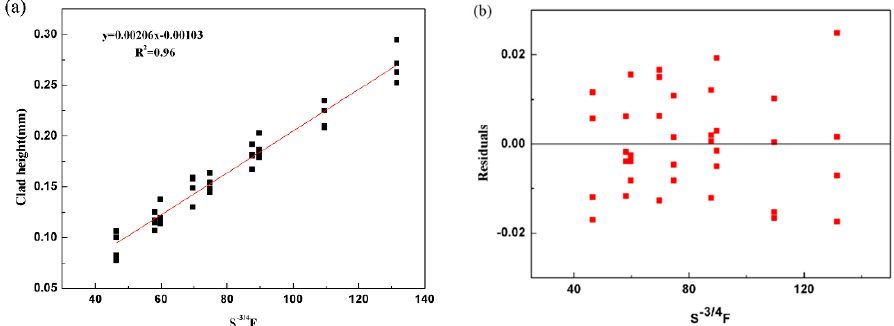
Figure 3. ( a ) The relationship between clad height and the two processing parameters (scanning speed ( S ) and powder feeding rate ( F )). ( b ) Residuals.